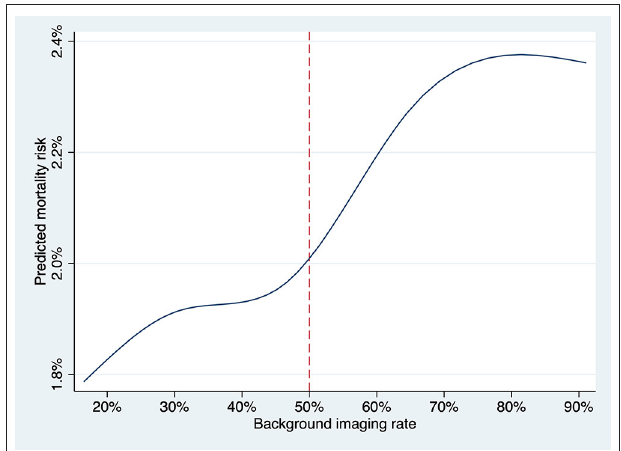
FIGURE 4 | The predicted risk of death at 1 year for the patient undergoing angiography-guided PCI was plotted against the background imaging rate as a continuous variable, fitting an M-spline curve with four interior knots. The threshold for increased mortality with background imaging rate was ∼